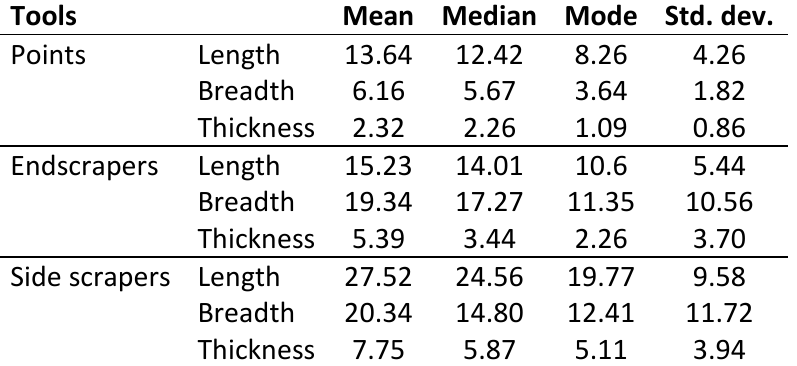
Table 4: Metric analysis of tools